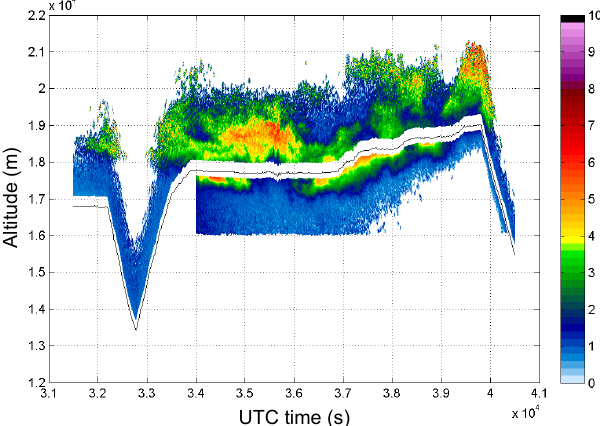
Figure 5. Backscatter ratio profile of the upward- and downward- looking lidars (MAL1 and MAL2) operated on board the M-55 Geophysica for the second part of the flight on 20 January 2010. A PSC field is visible along a flight leg of about 900km length. Due to limitations in the dynamical range of the lidars, data from a distance less than 200m from the aircraft are not